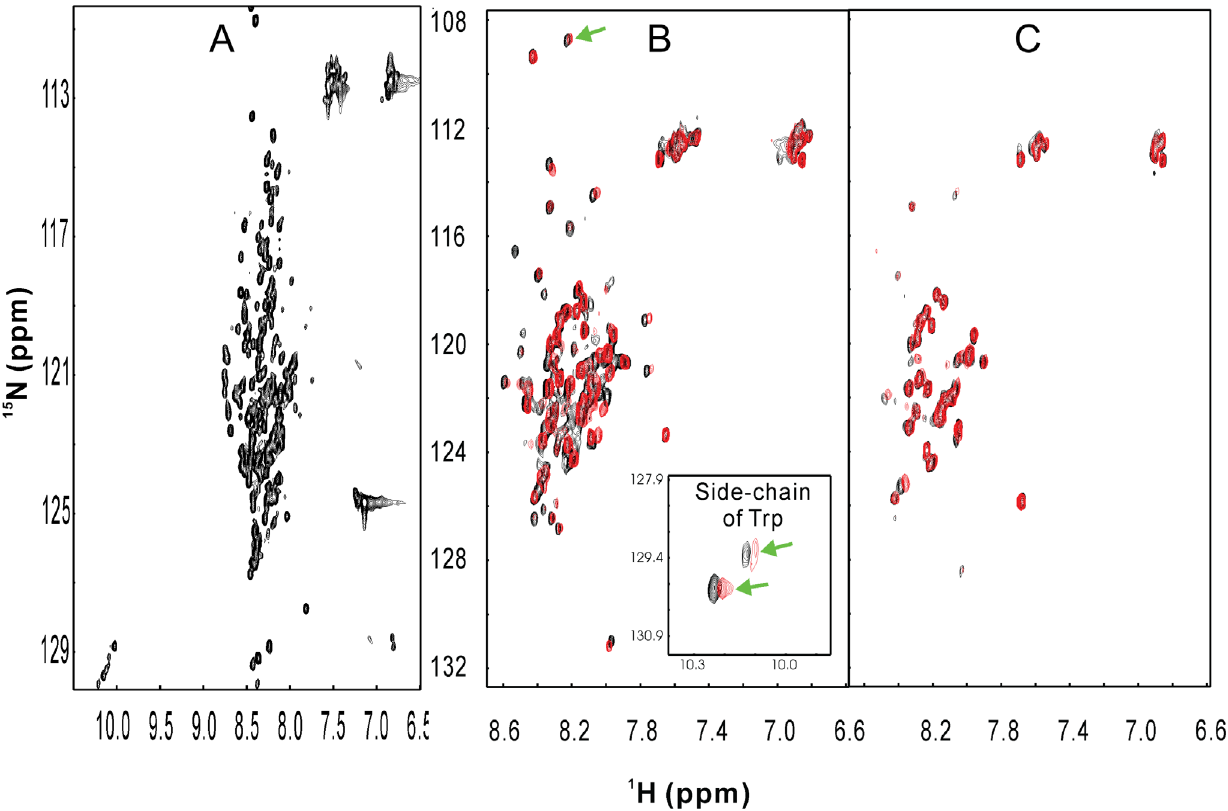
Figure 2. Conformational and binding properties of the full-length and two truncated ApLLP forms. ( A ) 1 H– 15 N NMR HSQC spectrum of the 15 N-labeled full-length ApLLP solubilized in unsalted water. ( B – C ) Superimposition of the 1 H– 15 N NMR HSQC spectra of ApLLP-87 ( B ) and ApLLP-55 ( C ) in the absence and in the presence of the DNA fragment at a molar ratio of 1/2 (protein/DNA). Shifted HSQC peaks arising from the Gly backbone and Trp side-chain (inlet) only presented in ApLLP-87 are indicated by green